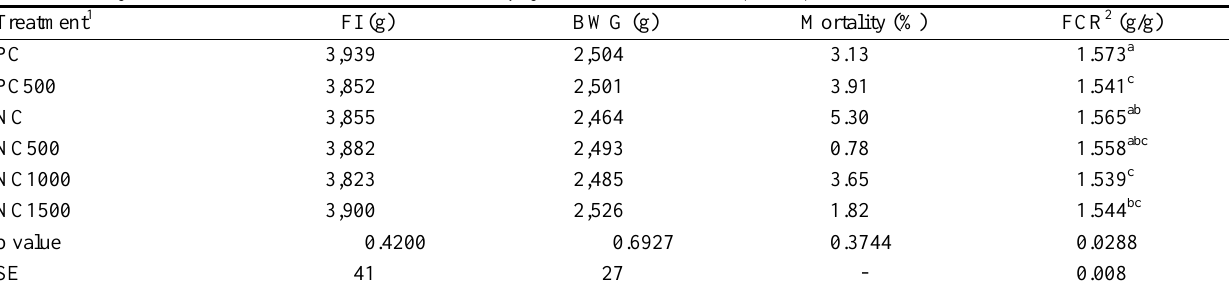
Table 4. Analysis of variance of the effect of P level and phytase inclusion on FCR, BWG, and FI of broilers at 35 d Treatment